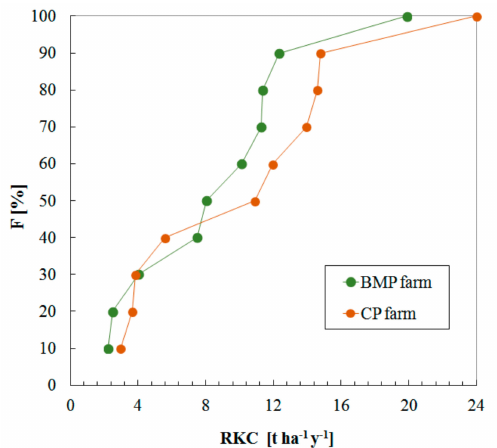
Figure 10. Distributions of yearly soil loss per unit LS and P, RKC (see RUSLE model), for the two investigated vineyards. F is the frequency of non-exceedance.